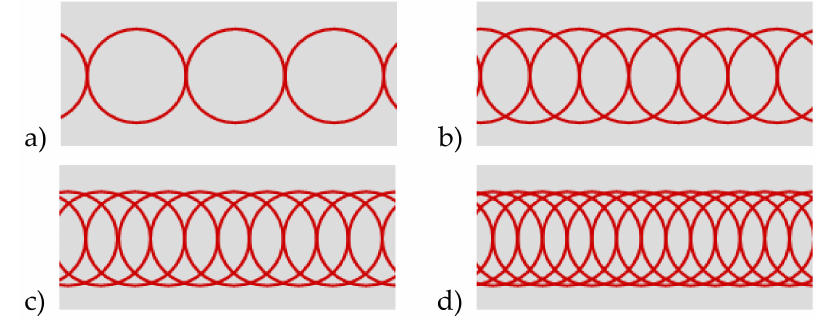
Figure 4. Pulse overlapping: ( a ) 0%; ( b ) 50%; ( c ) 67%; ( d ) 75%.